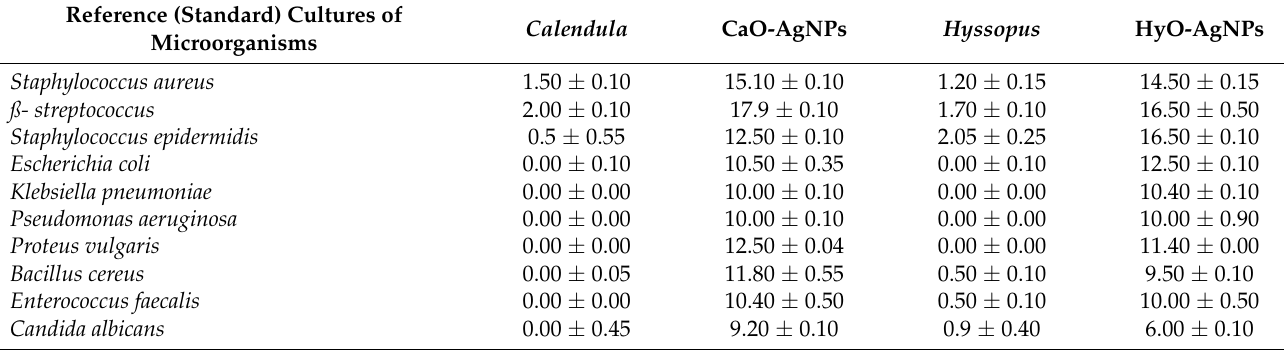
Table 1. The antibacterial activity of CaO-AgNPs and